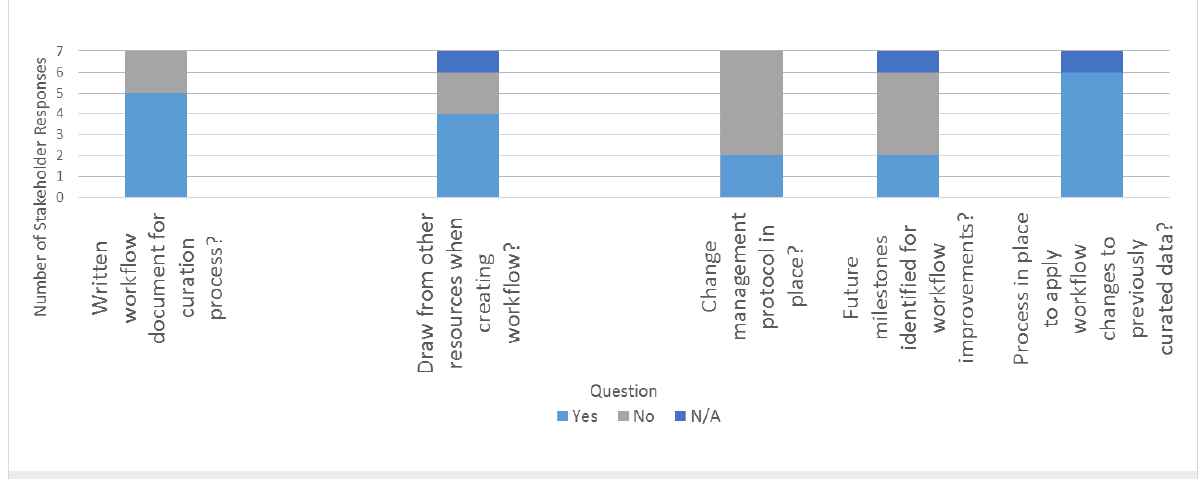
seven explicitly mark and/or remove “rejected data” (Figure